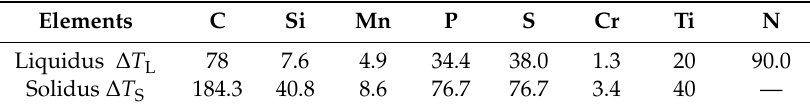
Table 2. The values of ∆ T L and ∆ T S ( ◦